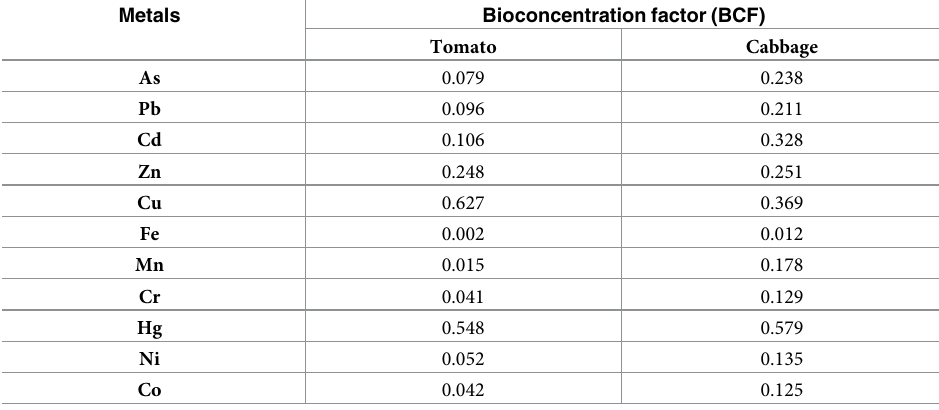
Table 5. Bioconcentration factor (BFC) of heavy metals analyzed for cabbage and tomato